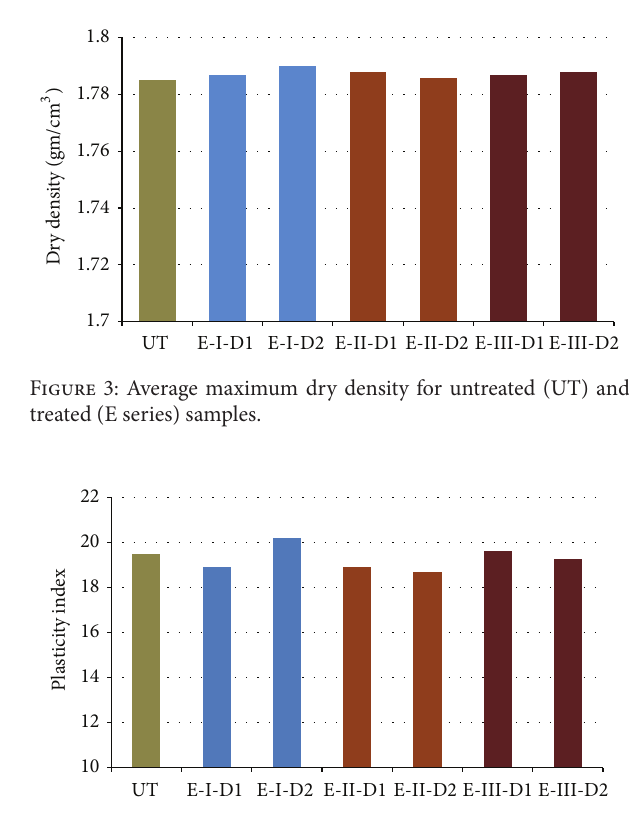
Figure 4: Plasticity indices for untreated (UT) and treated (E series)